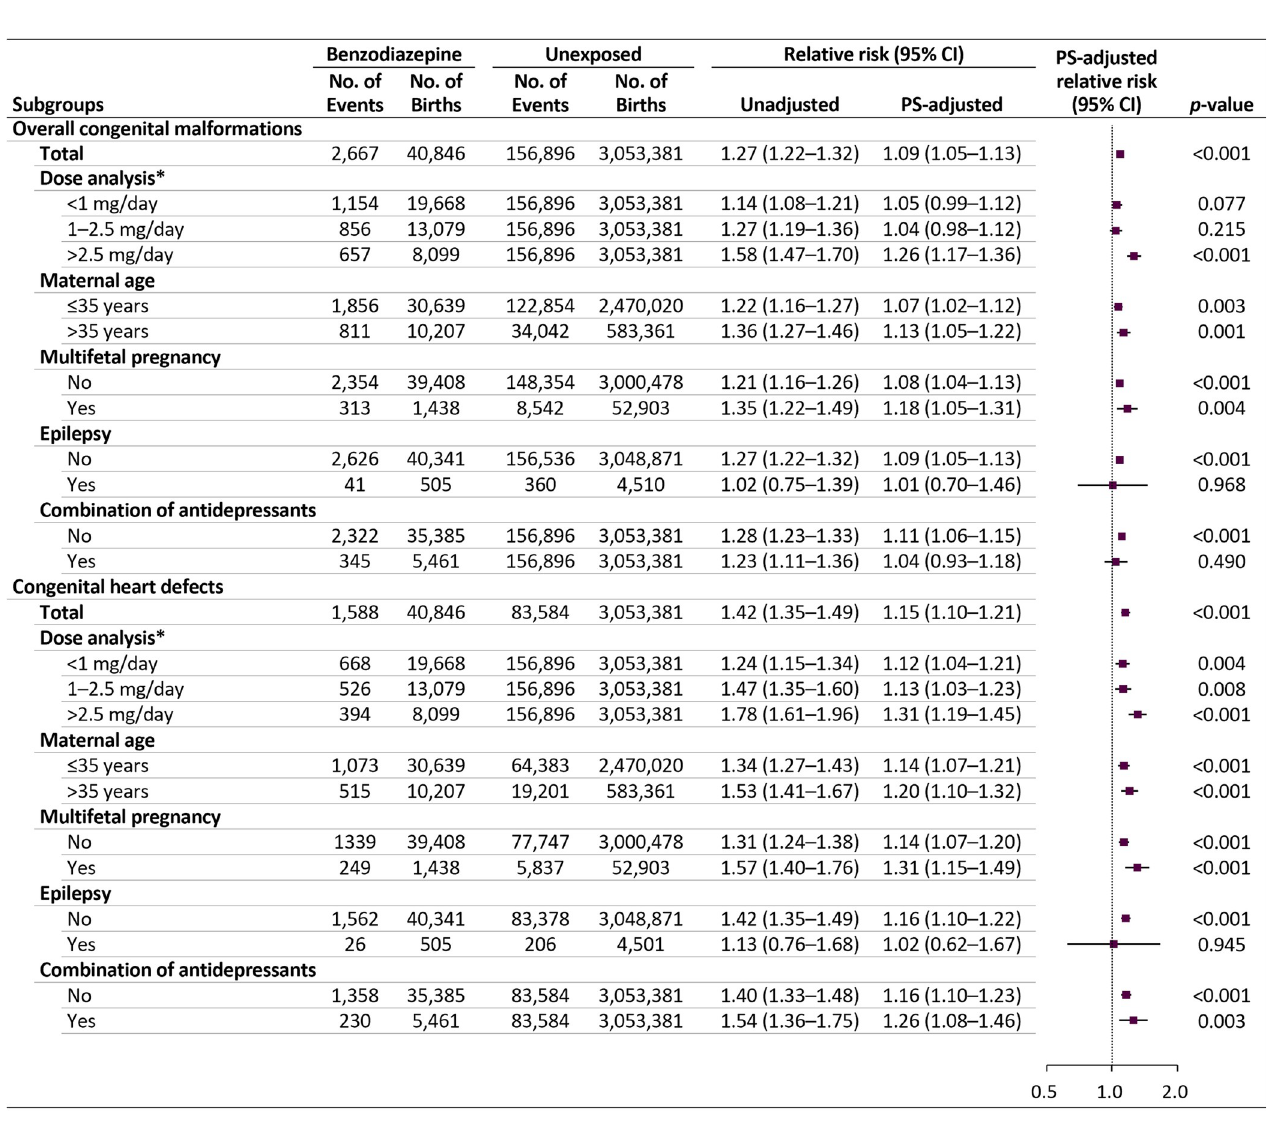
Fig 4. Risks of congenital malformations in infants following maternal exposure to benzodiazepines in the first trimester: subgroup analyses. CI, confidence interval; PS, propensity score. � Mean daily dose based on the lorazepam-equivalent dose.